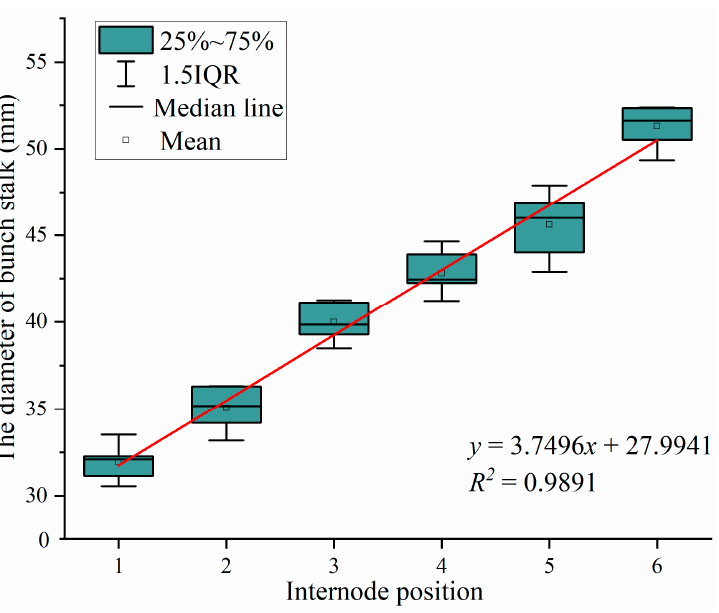
Figure 6. The relationship between the diameter of the bunch stalk and the internode positions.